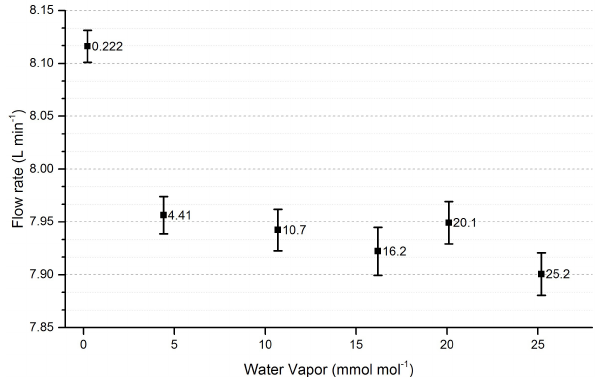
Fig. A1. Flow rate determined with a bubble meter, corrected for ambient pressure and temperature, against water vapor mole frac- tion for MFC 3 (Tylan FC-2900) operated at a constant flow rate set point. Each point shows the mean flow rate and the error bars represent the standard error with a sample size of 20. The numbers to the right of each point correspond to the water vapor content de- termined with the LI-7000.